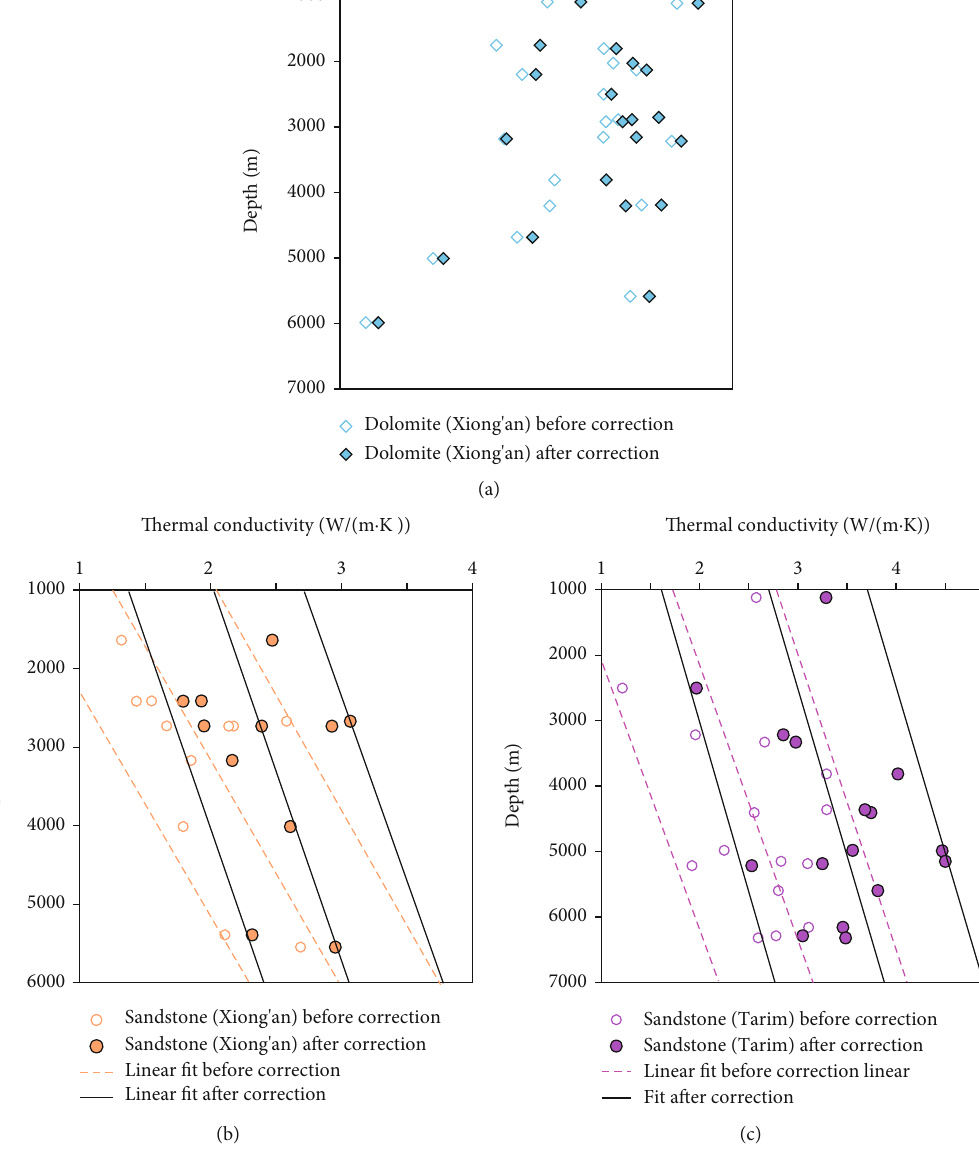
Figure 12: Comparison between corrected and uncorrected thermal conductivities. (a) Dolomite in Xiong ’ an New Area. (b) Sandstone in Xiong ’ an New Area. (c) Sandstone in Tarim